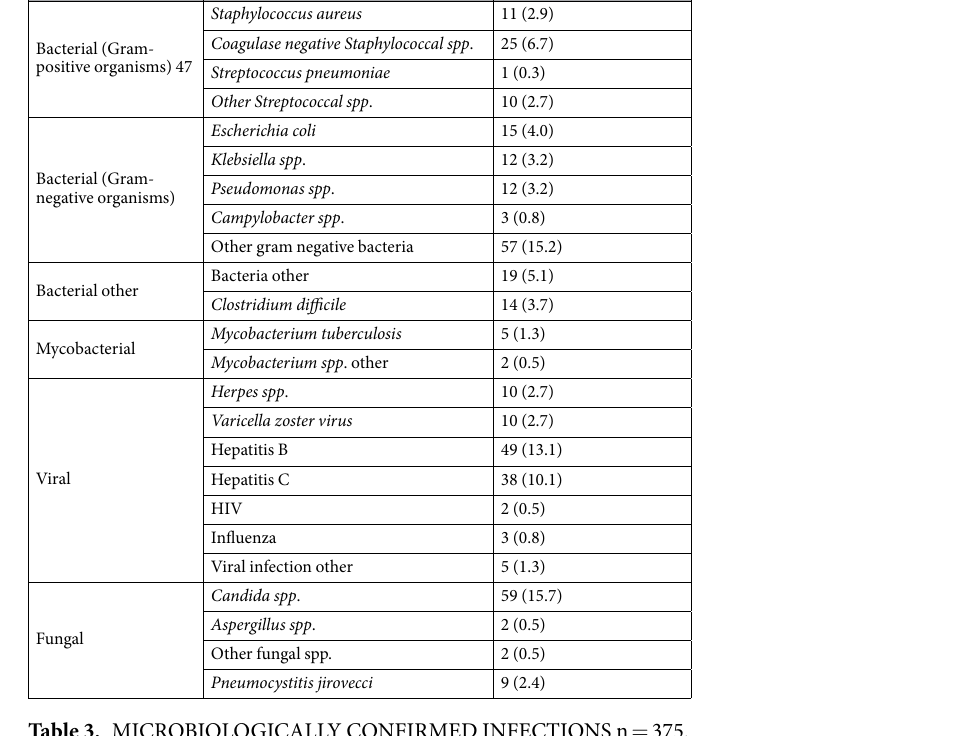
Table 3. MICROBIOLOGICALLY CONFIRMED INFECTIONS n =